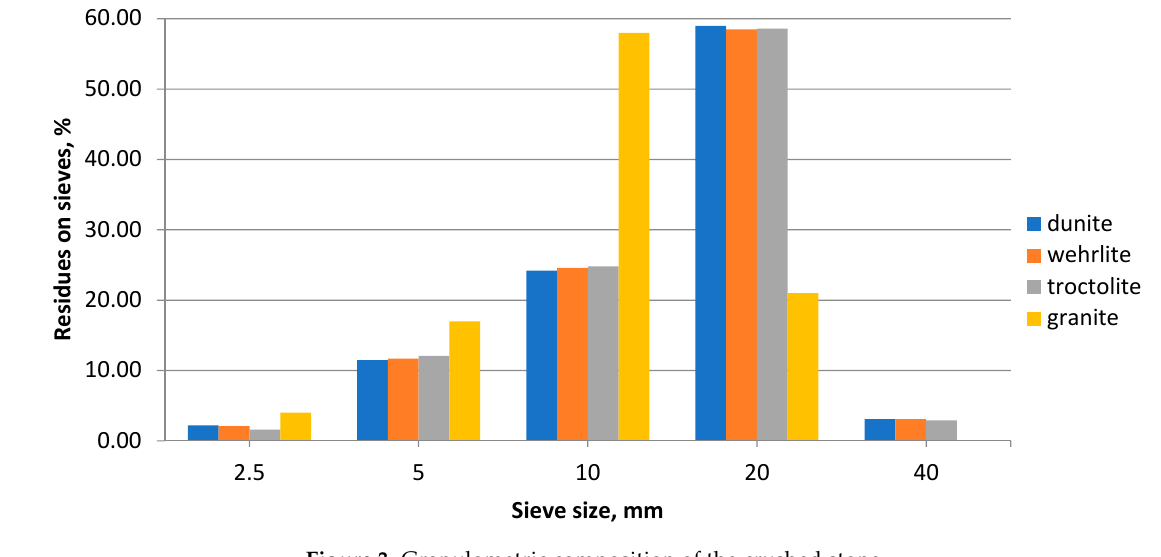
Figure 3. Granulometric composition of the crushed stone.